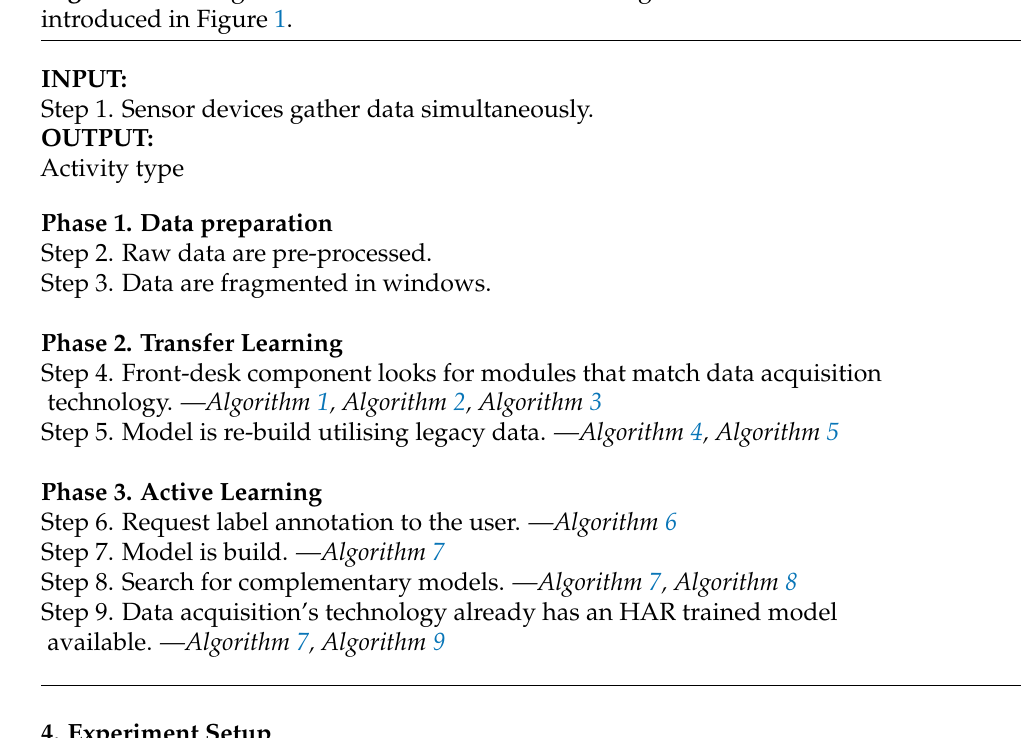
Algorithm 10 Organised list of the TL-FmRADL’s algorithms in order of execution as introduced in Figure